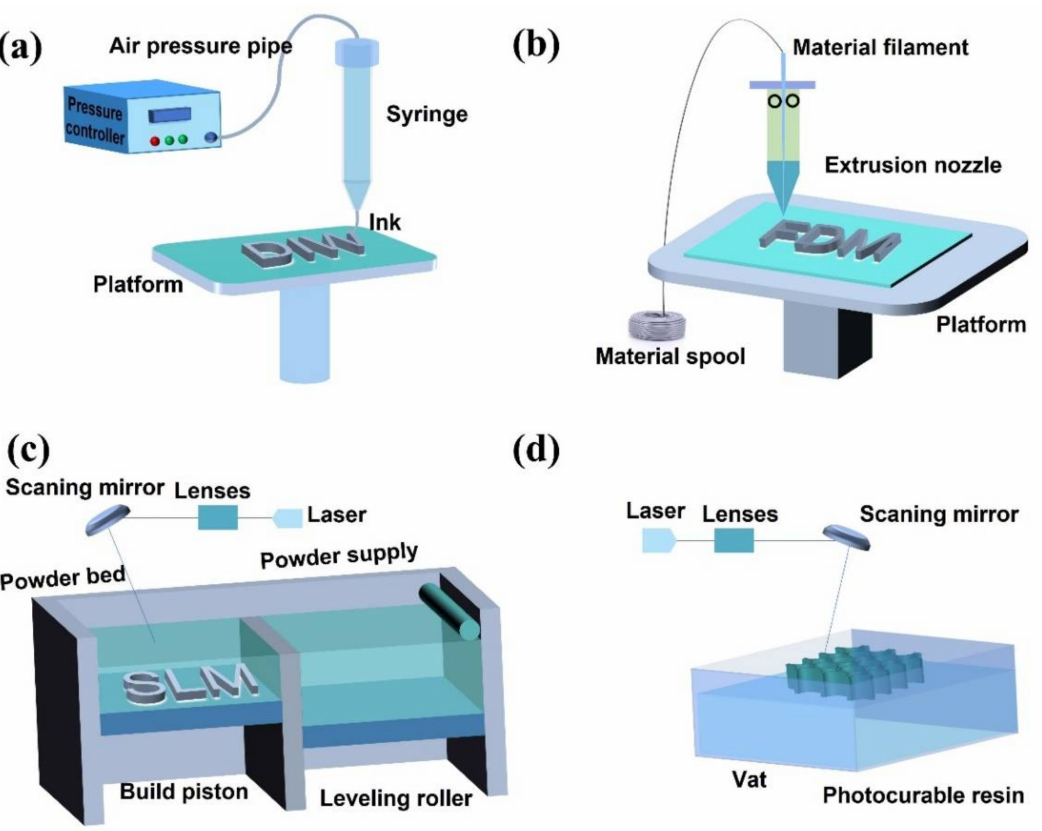
Figure 1. Schematic diagrams for ( a ) DIW, ( b ) FDM, ( c ) SLM and ( d ) SLA 3D printing